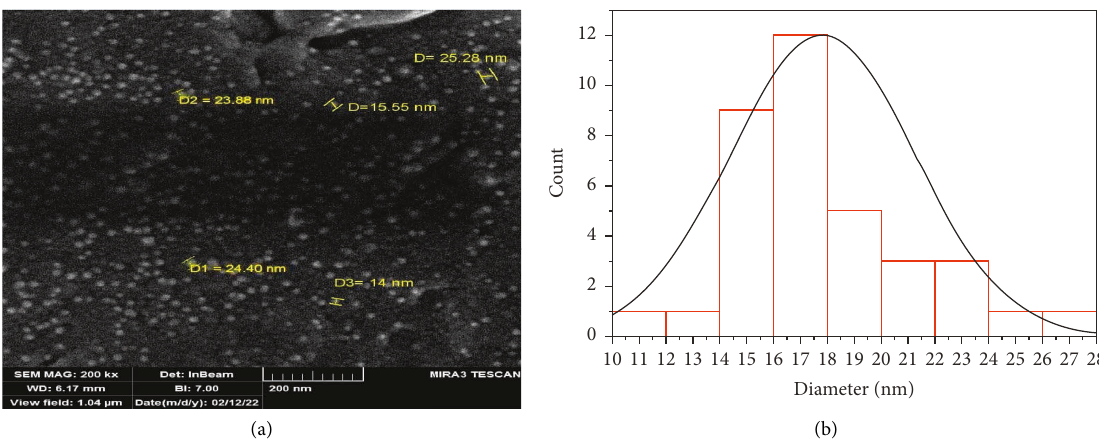
Figure 5: (a) SEM image showing AgNPs at the scale of 200nm and (b) the size distribution of green synthesized silver nanoparticles.